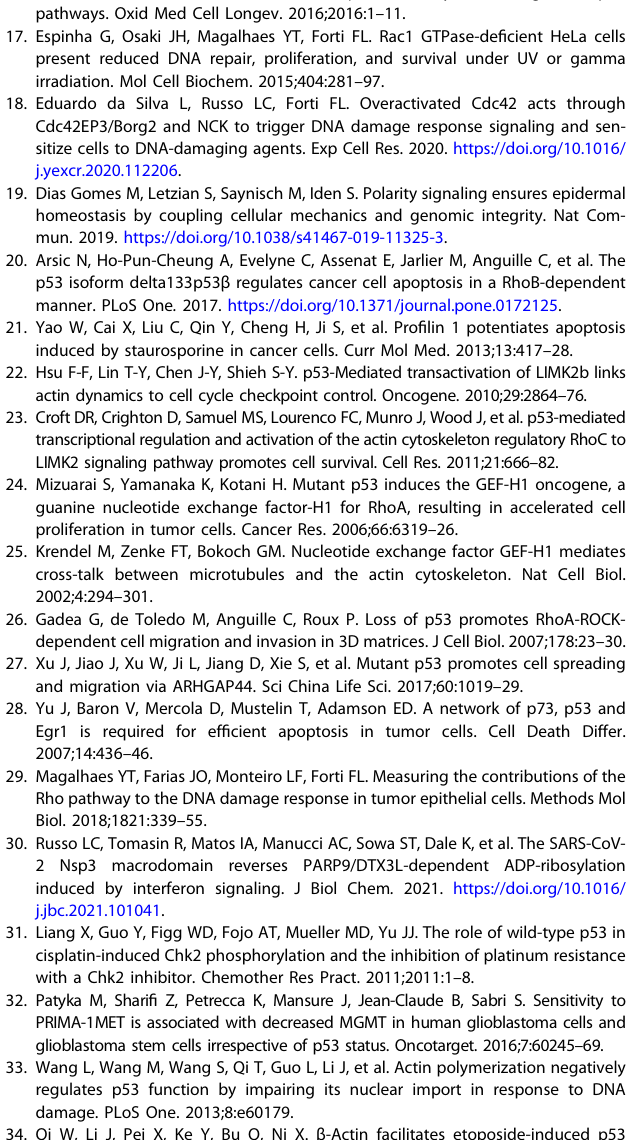
Fig. 8 Radioresistance of GBM cell clones can be modulated via the Rho pathway. A Flowchart of the protocol for generating IR-resistant U87MG clones over eleven consecutive weeks until the fi nal cumulative dose of 60 Gy was reached. B IR R-1 clones display higher resistance and viability than parental U87-MG cells 72 h after exposure to increasing doses of IR. C IR R-1 cells exhibit distinct F-actin structures, with increased stress fi ber formation and actin protrusions (F-actin (labeled with Alexa Fluor 488-phalloidin) in green and DAPI in blue). D IR R-1 cells exhibit increased Rho pathway activity (RhoA-GTP, pCFL1, and PFN1) compared to U87-MG cells, as shown by immunoblot analysis and pulldown assays. On the other hand, RhoB activity is diminished in IR R-1 cells. E Proteins related to distinct DNA damage signaling pathways were analyzed by immunoblotting as follows: (i) p53 pathway, (ii) DDR pathway, (iii) NHEJ repair, and (iv) HR repair. IR R-1 cells show increased expression of p53 associated with lower expression of p21, increased levels of H2AX and Chk2 phosphorylation, and increased levels of NHEJ and HR proteins (Ku80 and Rad51, respectively) compared to those in U87-MG cells. F C3 toxin treatment reverses IR resistance in IR R-1 cells, since the viability of the IR-resistant clones under Rho inhibition is reduced almost to the level in parental U87-MG cells, as determined by the IC 50 values. G IR R-1 cells show high numbers of γ H2AX foci under stress-free conditions; however, these cells show lower numbers of γ H2AX foci after IR, and these numbers are slightly decreased by C3 toxin treatment. H p53 knockdown prevents the effect of Rho inhibition on reversing the IR-resistant phenotype of IR R-1 cells exposed to different doses of IR. I Schematic model of GBM resistance acquisition and reversion by targeting of the Rho and p53 pathways. Illustrations were created with BioRender.com. The immunoblot images are representative of three independent experiments. Immuno fl uorescence images were acquired with a 63x objective in a high-throughput image acquisition system, and the scale bars represent 10 µM. The graphs show the mean ± SD of at least three independent experiments, with individual replicate dots, as analyzed by two-way ANOVA with Sidak ’ s multiple comparison